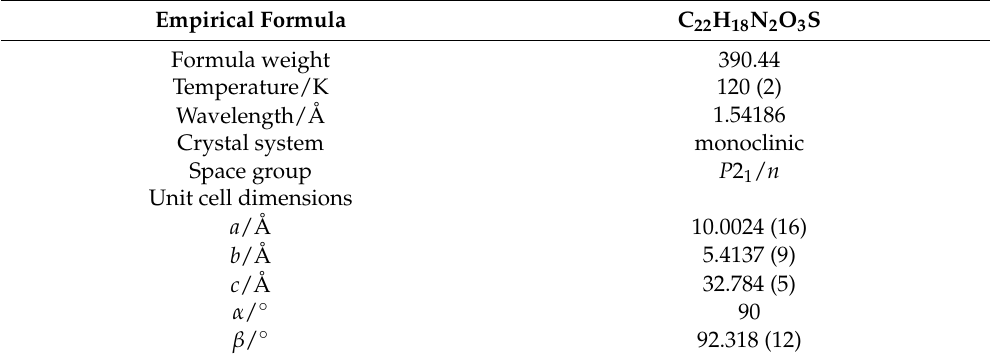
Table 1. Crystal data and structure refinement details for 25